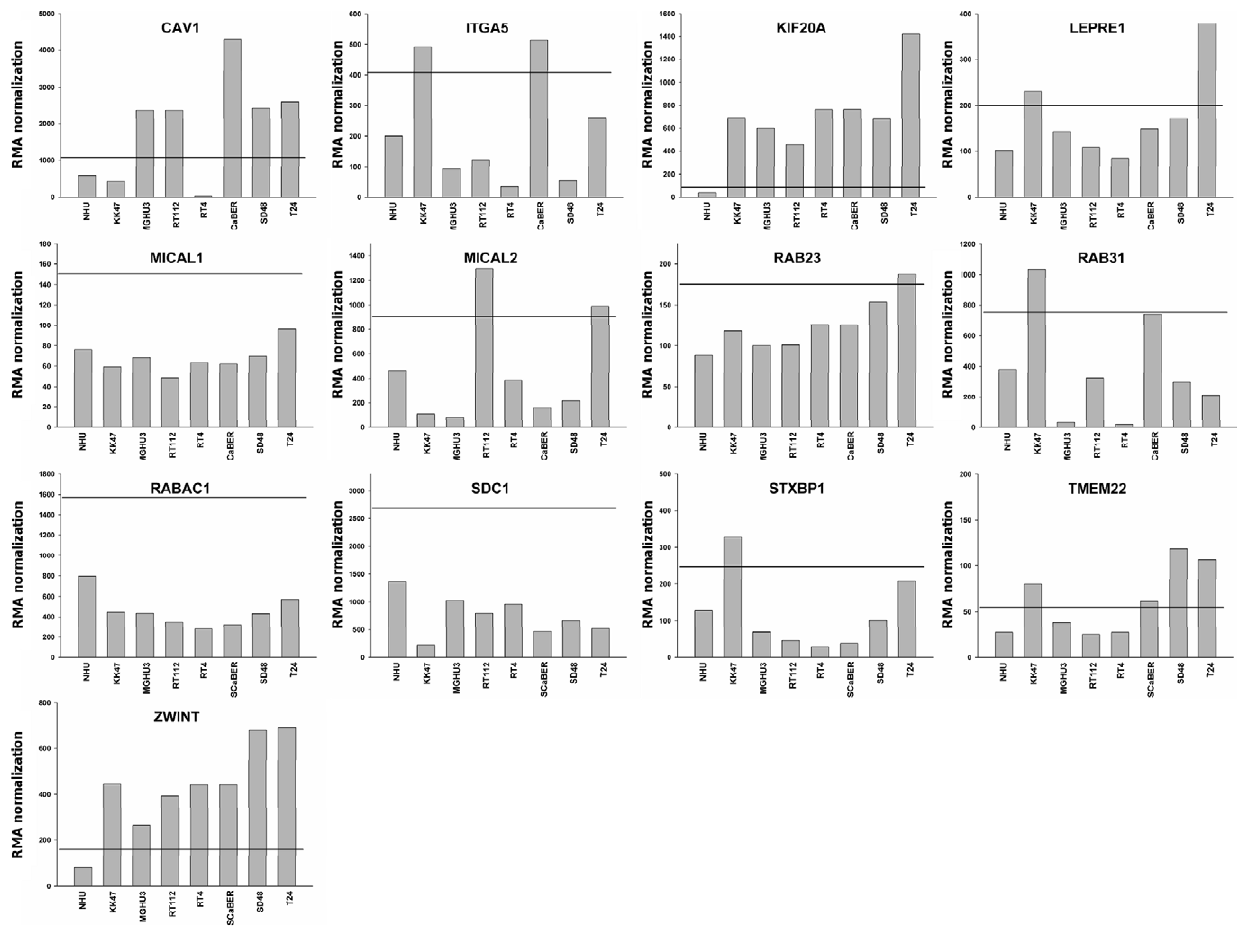
Figure 6. Up-regulated gene expression in normal human urothelium (NHU) cells and bladder tumor cell lines. The expression of the 13 up-regulated genes (Table 2 and 3) ( CAV1 , ITGA5 , KIF20A , LEPRE1 , MICAL1 , MICAL2 , RAB23 , RAB31 , RABAC1 , SDC1 , STXBP1 , TMEM22 and ZWINT ) was measured by Affymetrix array in 7 bladder cancer cell lines (KK47, MGHU3, RT112, RT4, SCaBER, SD48 and T24) and normal human urothelial (NHU) cells grown in culture. The threshold for genes to be considered as up-regulated in tumor cell lines (2 fold the expression measured in NHU cells) is represented by a black line.